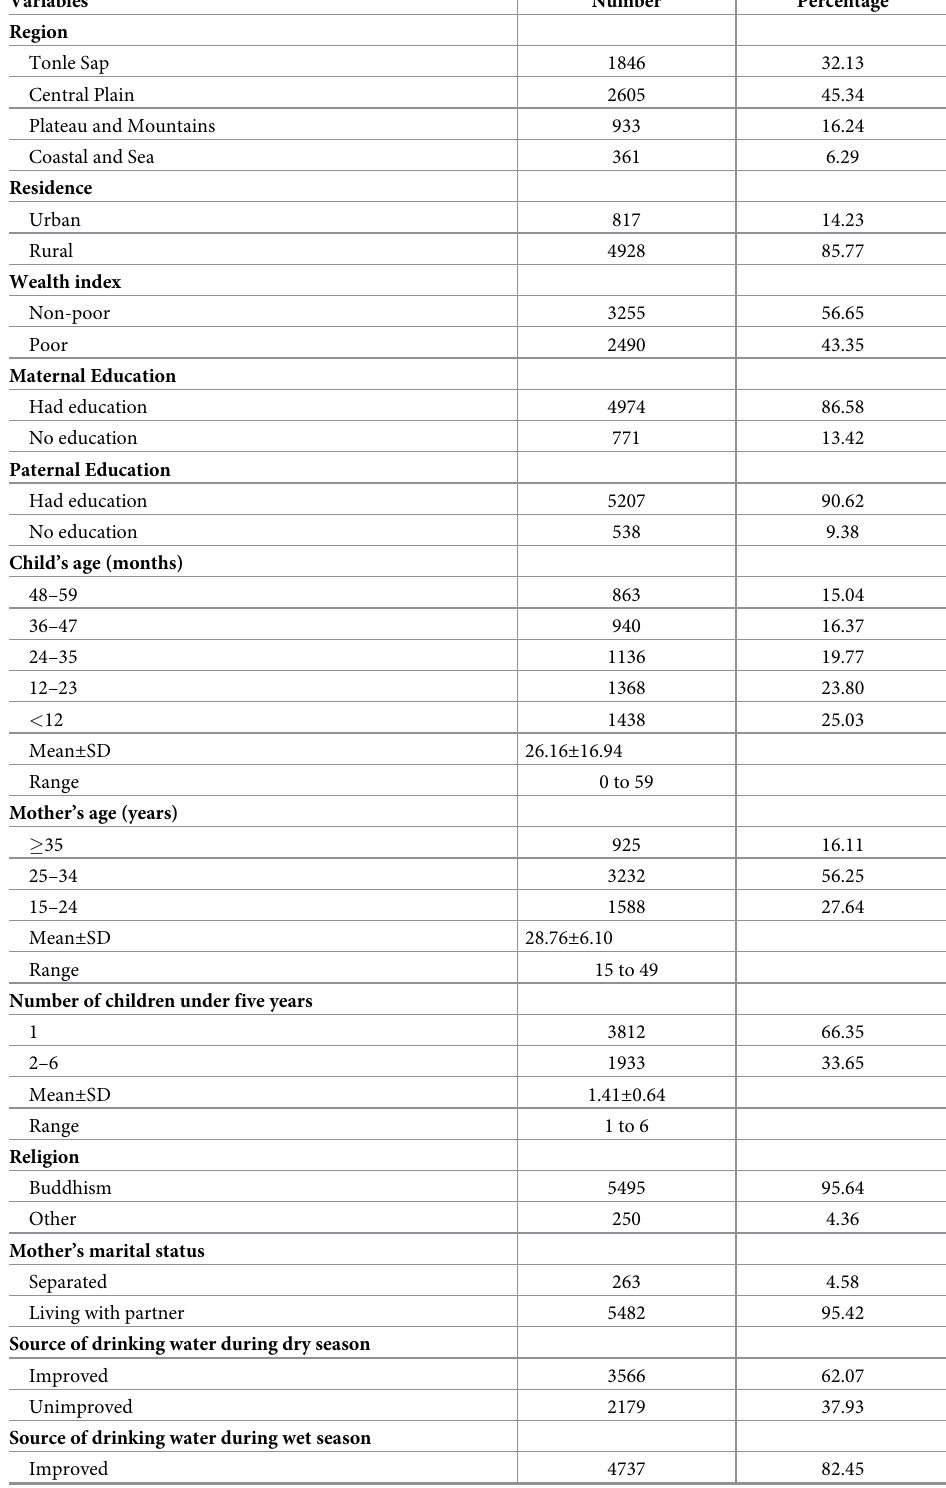
Table 1. Characteristics of households in Cambodia, 2014 (n =